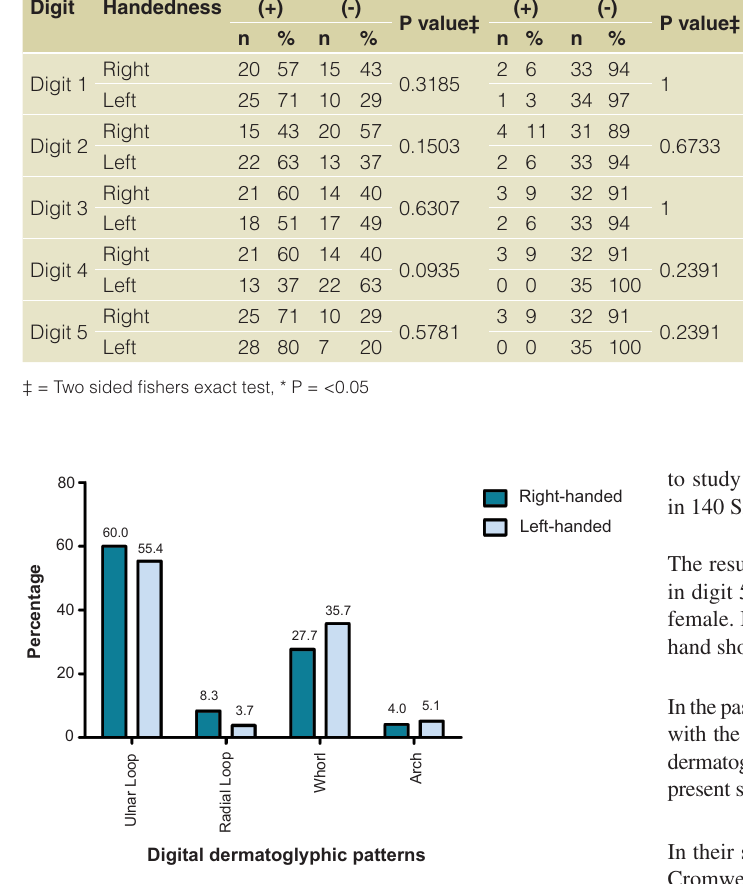
Figure 3. Digital dermatoglyphics pattern distributions in both hands of males.